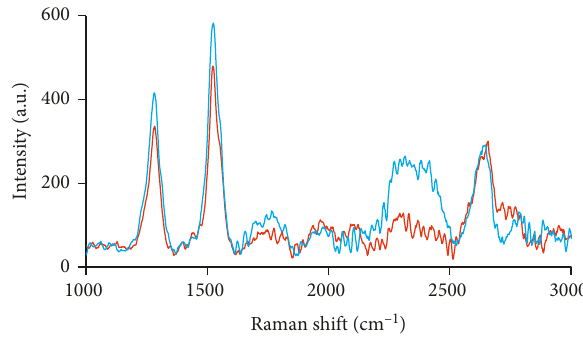
Figure 1: Two typical Raman characteristic (514nm wavelength) of chemical vapor deposited (CVD) graphene with a high degree of disorder [37–39] on copper foil measured at two arbitrary